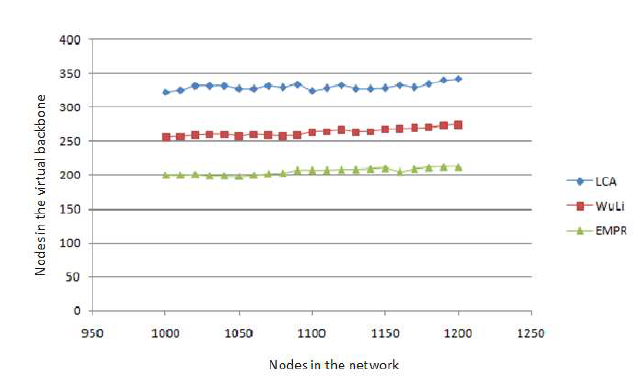
Figure 4. Number of nodes in the virtual backbone when nodes are connected to the network